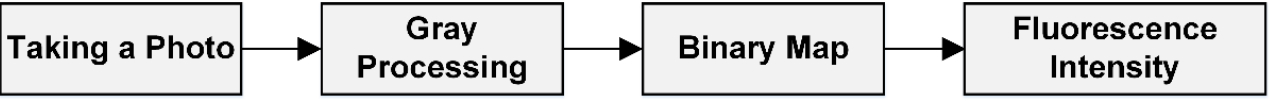
Figure 5. Working principle of the app for fluorescence signal processing.